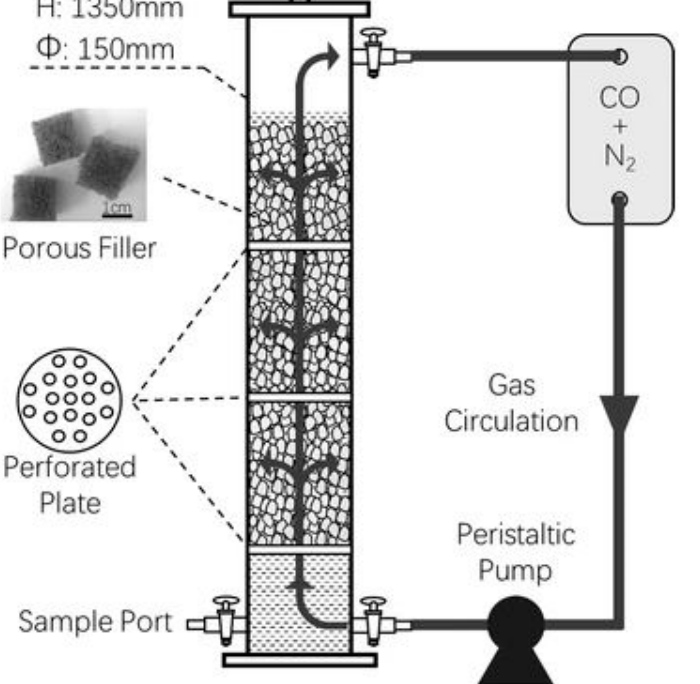
Figure 4. Schematic of the reactor used for carboxylates production from CO using open culture by He et al. (2018). Reprinted from [70].